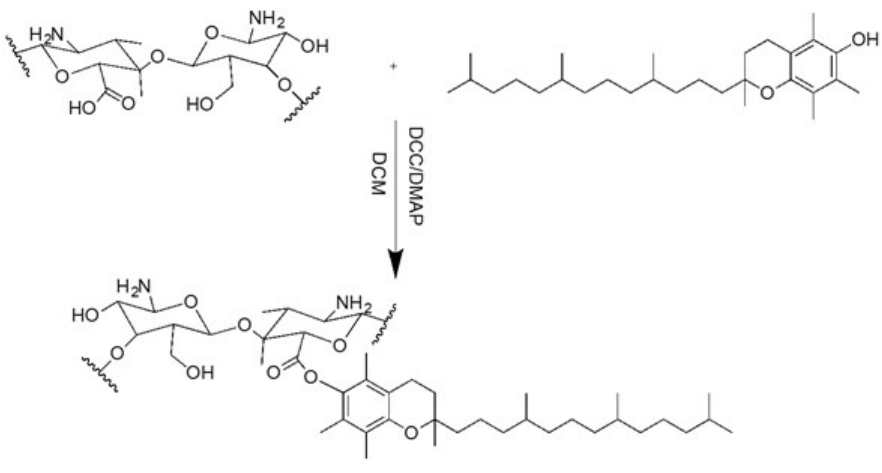
Scheme 1. Scheme of synthetic route of CC- α -T.